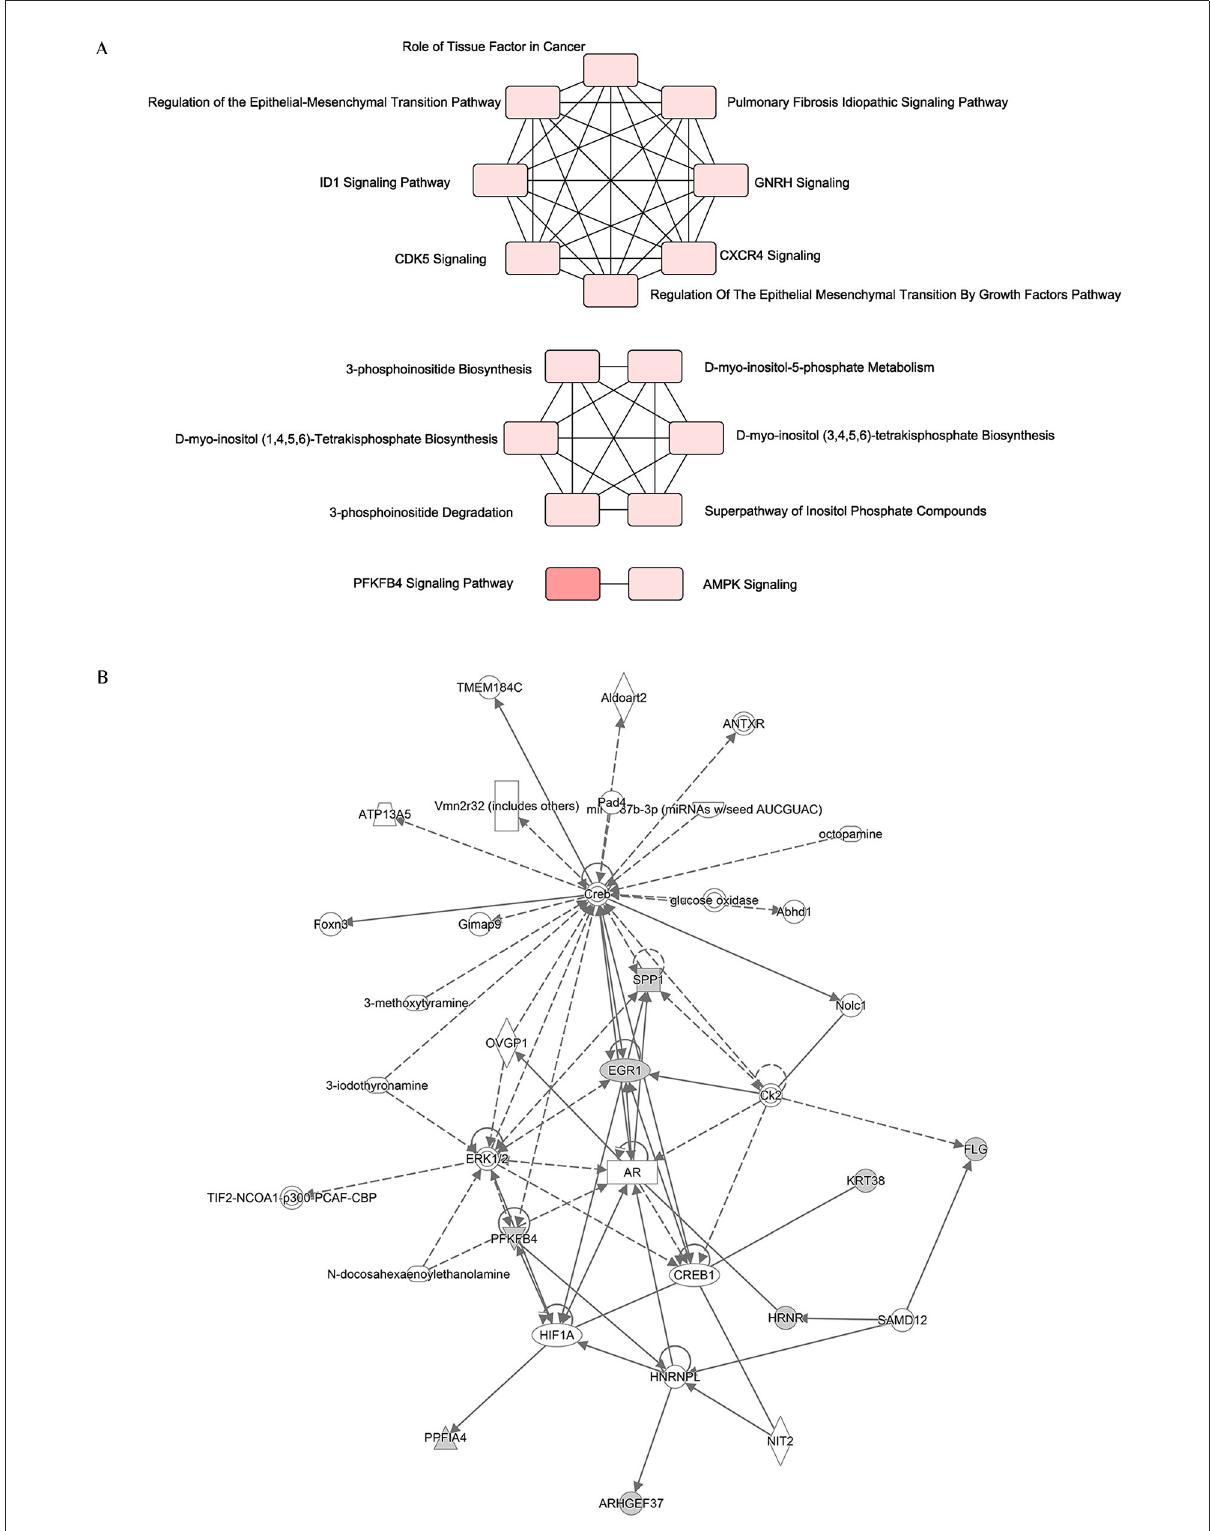
FIGURE6 Functional network of the twelve hub genes. (A) An analysis of the core functions of twelve hub genes by QIAGEN Ingenuity Pathway Analysis (IPA). (B) An analysis of the core interaction network of twelve hub genes by